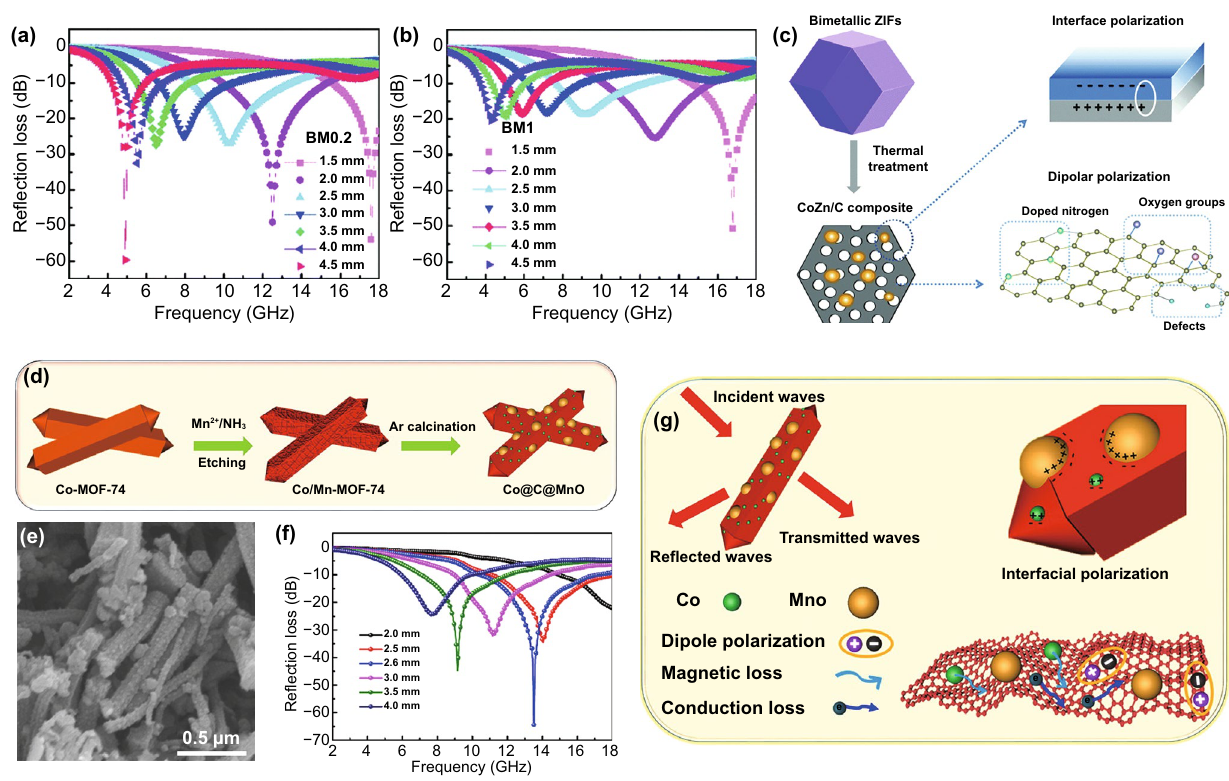
Fig. 11 RL-f curves of CoZn/C with the Zn/Co of a 0.2 and b 1. c Schematic illustration of the synthesis of CoZn/C composites. Reprinted with permission from Ref. [118]. d Schematic illustration of preparation process, e SEM image, f RL-curves and g MA mechanism diagram of Co@C@MnO nanorod. Reprinted with permission from Ref.